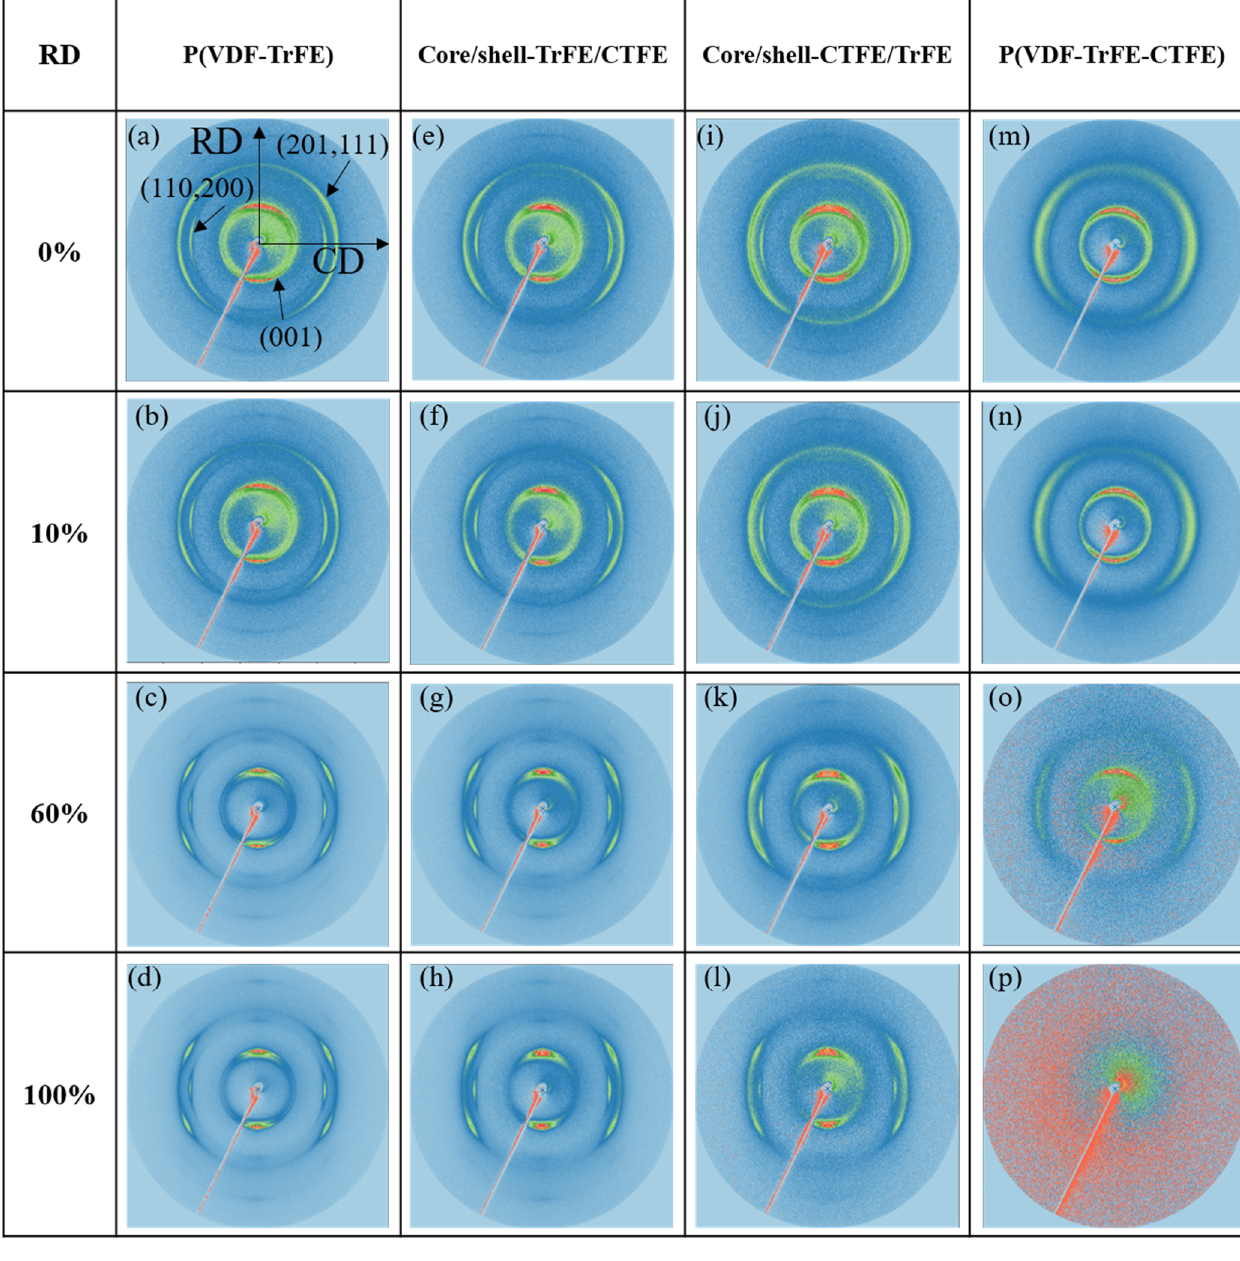
Figure 3. 2D WAXS patterns in the single and coaxial electrospun membranes at the designated strains in RD. ( a – d ) are patterns of single P(VDF-TrFE). ( e – h ) are patterns of core/shell-TrFE/CTFE. ( i – l ) are patterns of core/shell-CTFE/TrFE. ( m – p ) are patterns of single P(VDF-TrFE-CTFE).